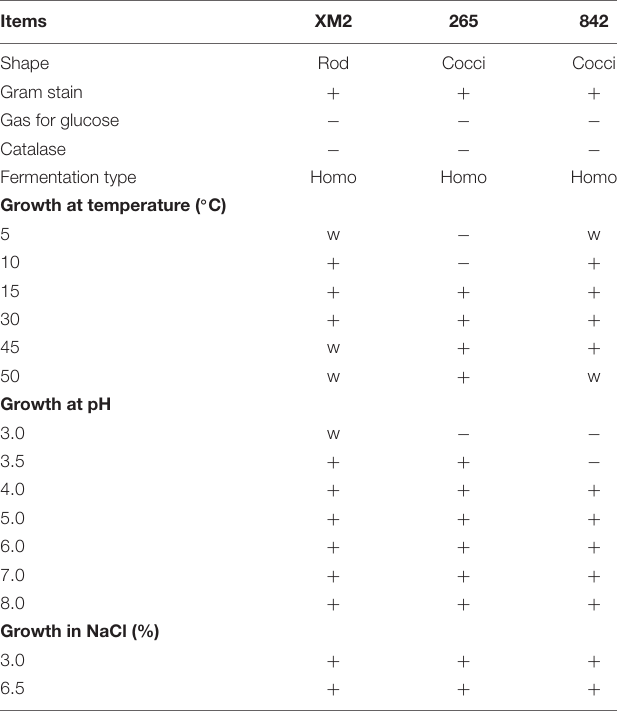
TABLE 1 | The selection of isolated lactic acid bacteria on the base of the morphological and physiological tests. Items XM2 Shape Rod Cocci Cocci Gram stain + + + Gas for glucose − − − Catalase